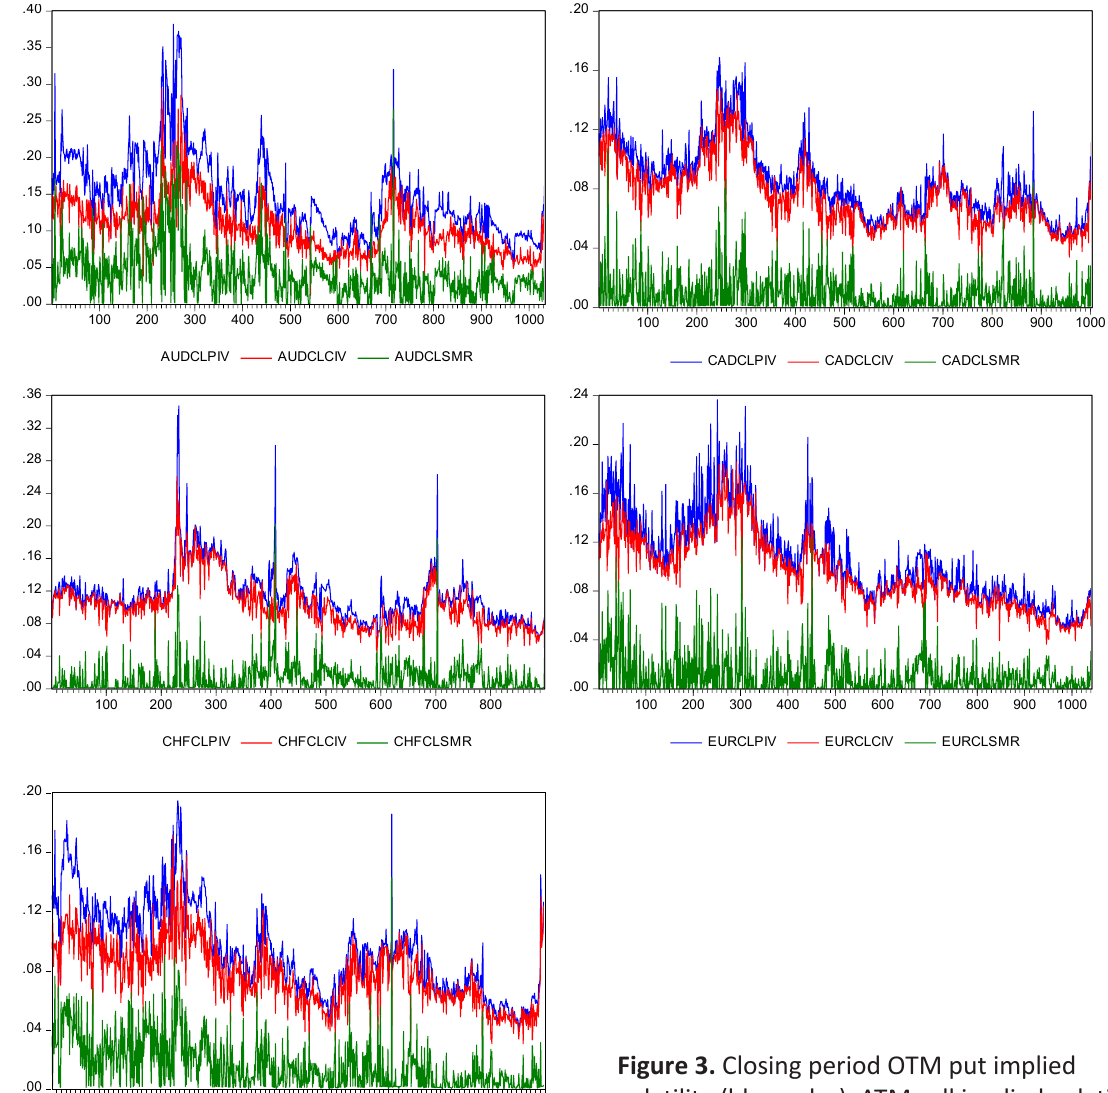
Figure 3. Closing period OTM put implied volatility (blue color), ATM call implied volatility (red color) and volatility smirk (green